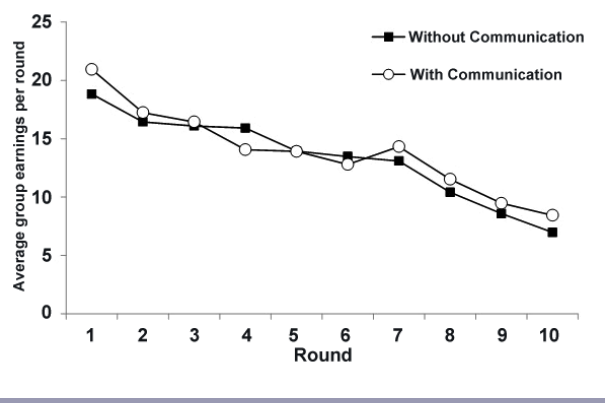
Fig. 2. Average earnings for the 34 participant groups in games without participant communication and with communication after each round.